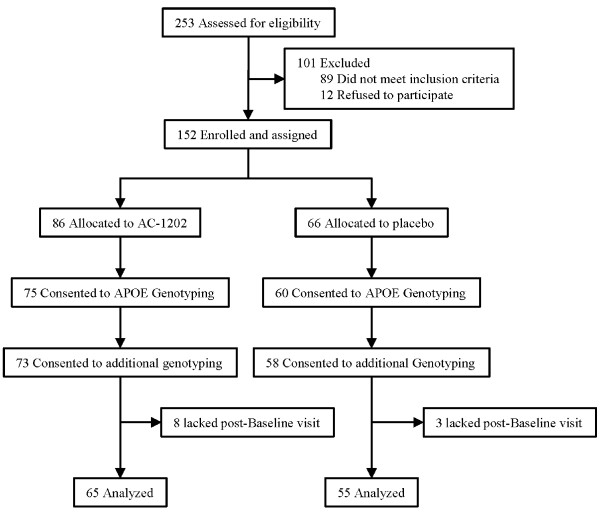
Subject Disposition.